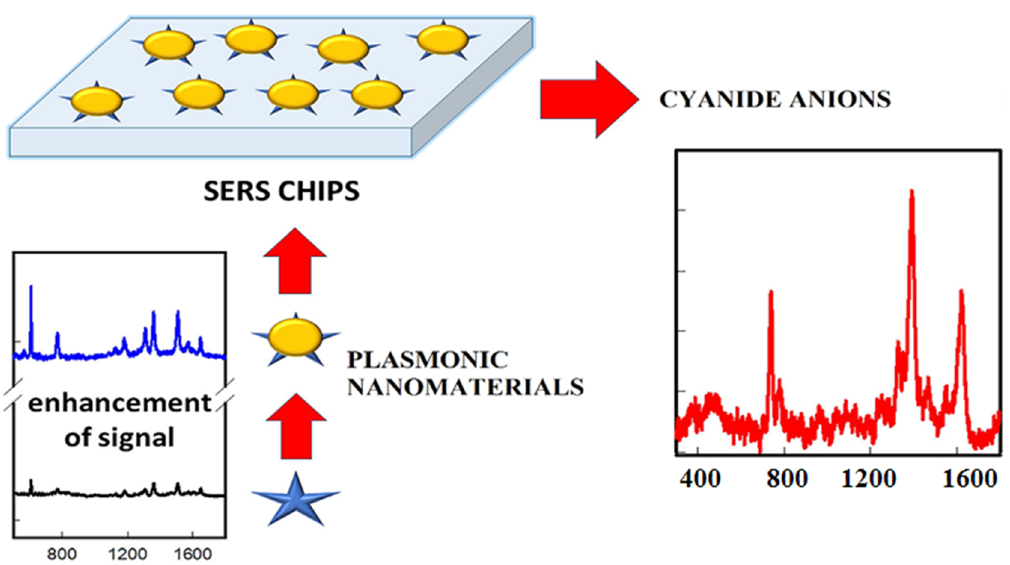
Figure 8. Schematic illustration of the sample preparation for the detection of cyanide by plasmonic MNPs. Figure reproduced from Ref. [145] with permission from MDPI.